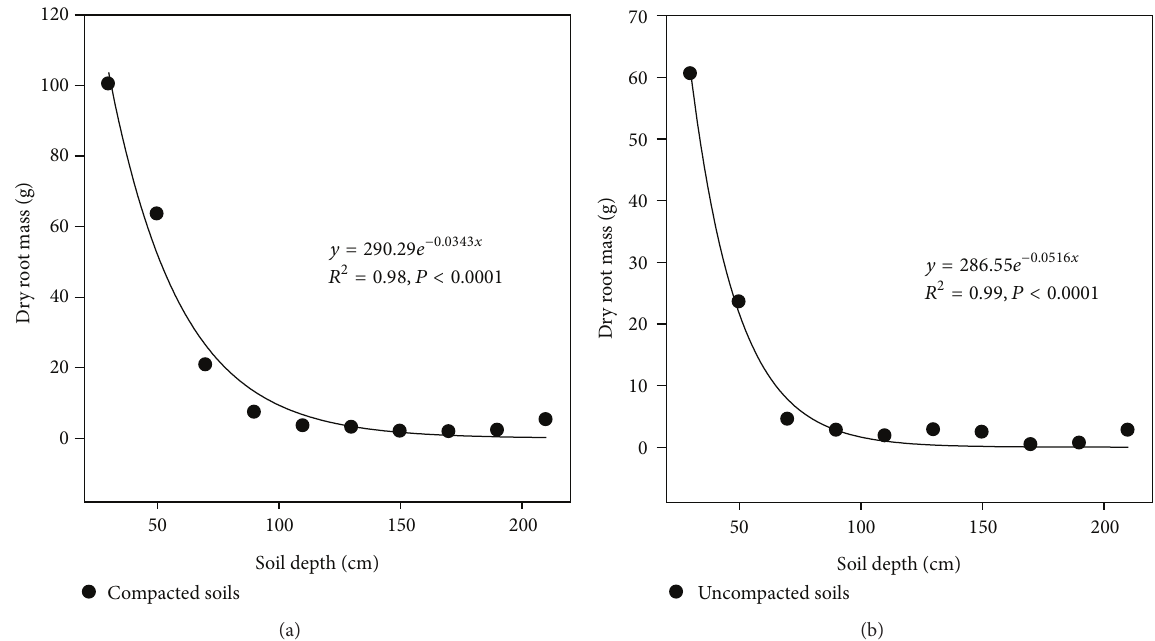
Figure 2: Relationship between dry root biomass ( 𝑦 ) of Quercus petraea L. and soil depth ( 𝑥 ) in compacted soils (a) and uncompacted soils (b) of reclaimed post-lignite mining